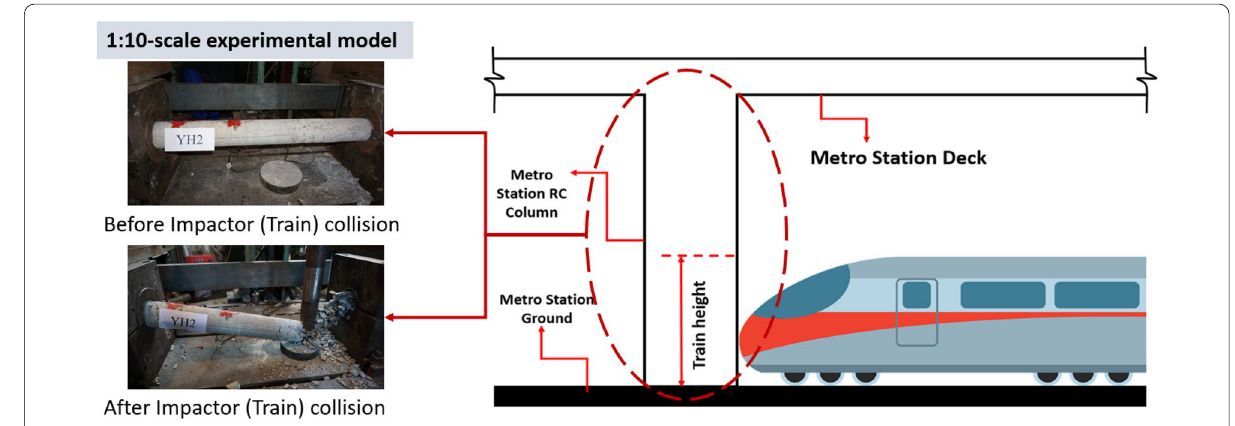
Fig. 1 Schematic diagram of RC member with a train